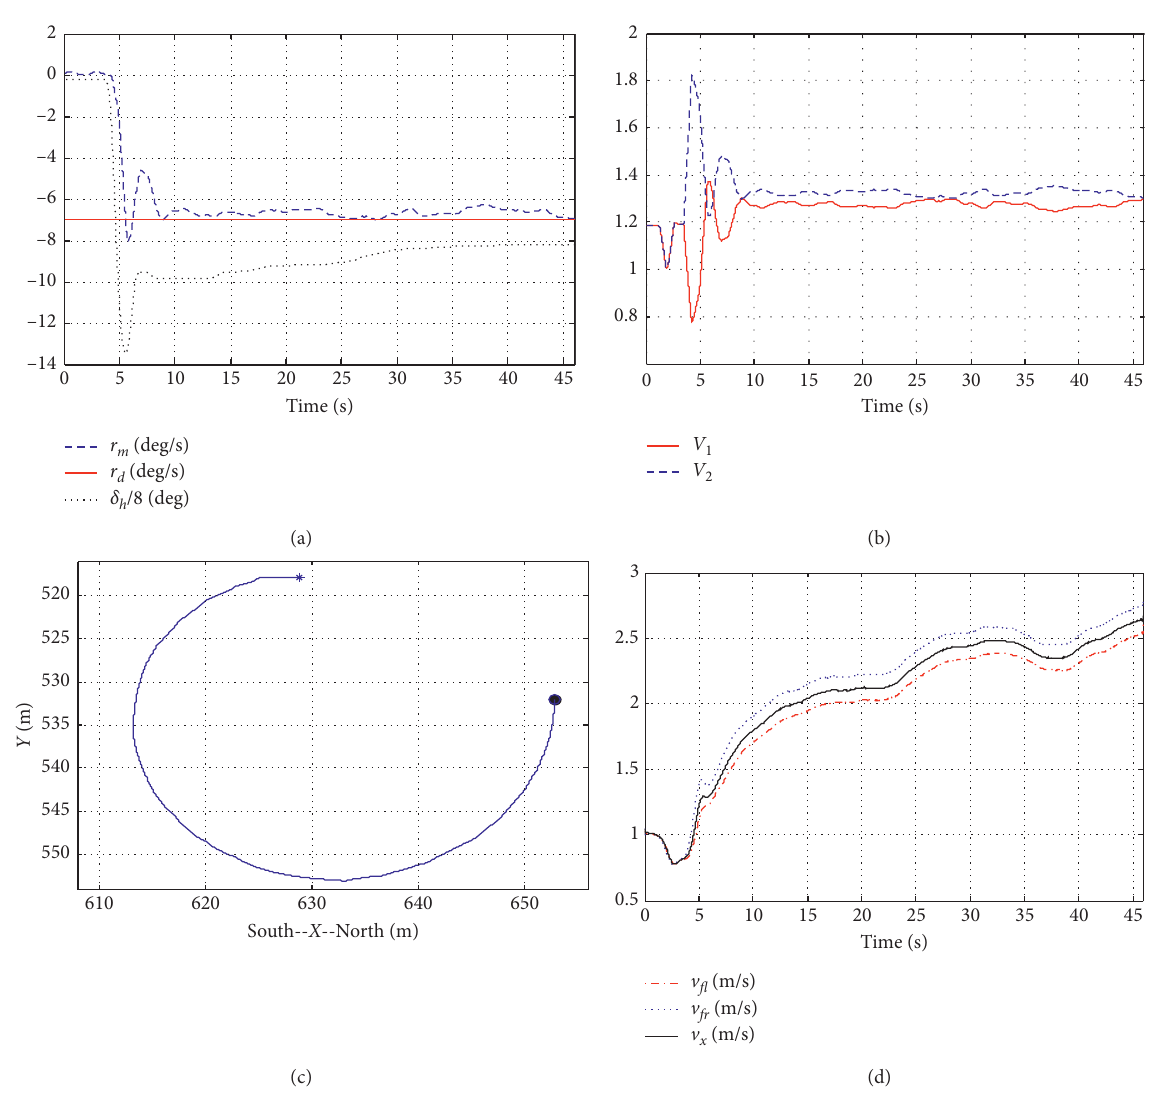
Figure 7: The result of the fixed yaw rate tracking. (a) Time (s). (b) Time (s). (c) South- X -North. (d) Time